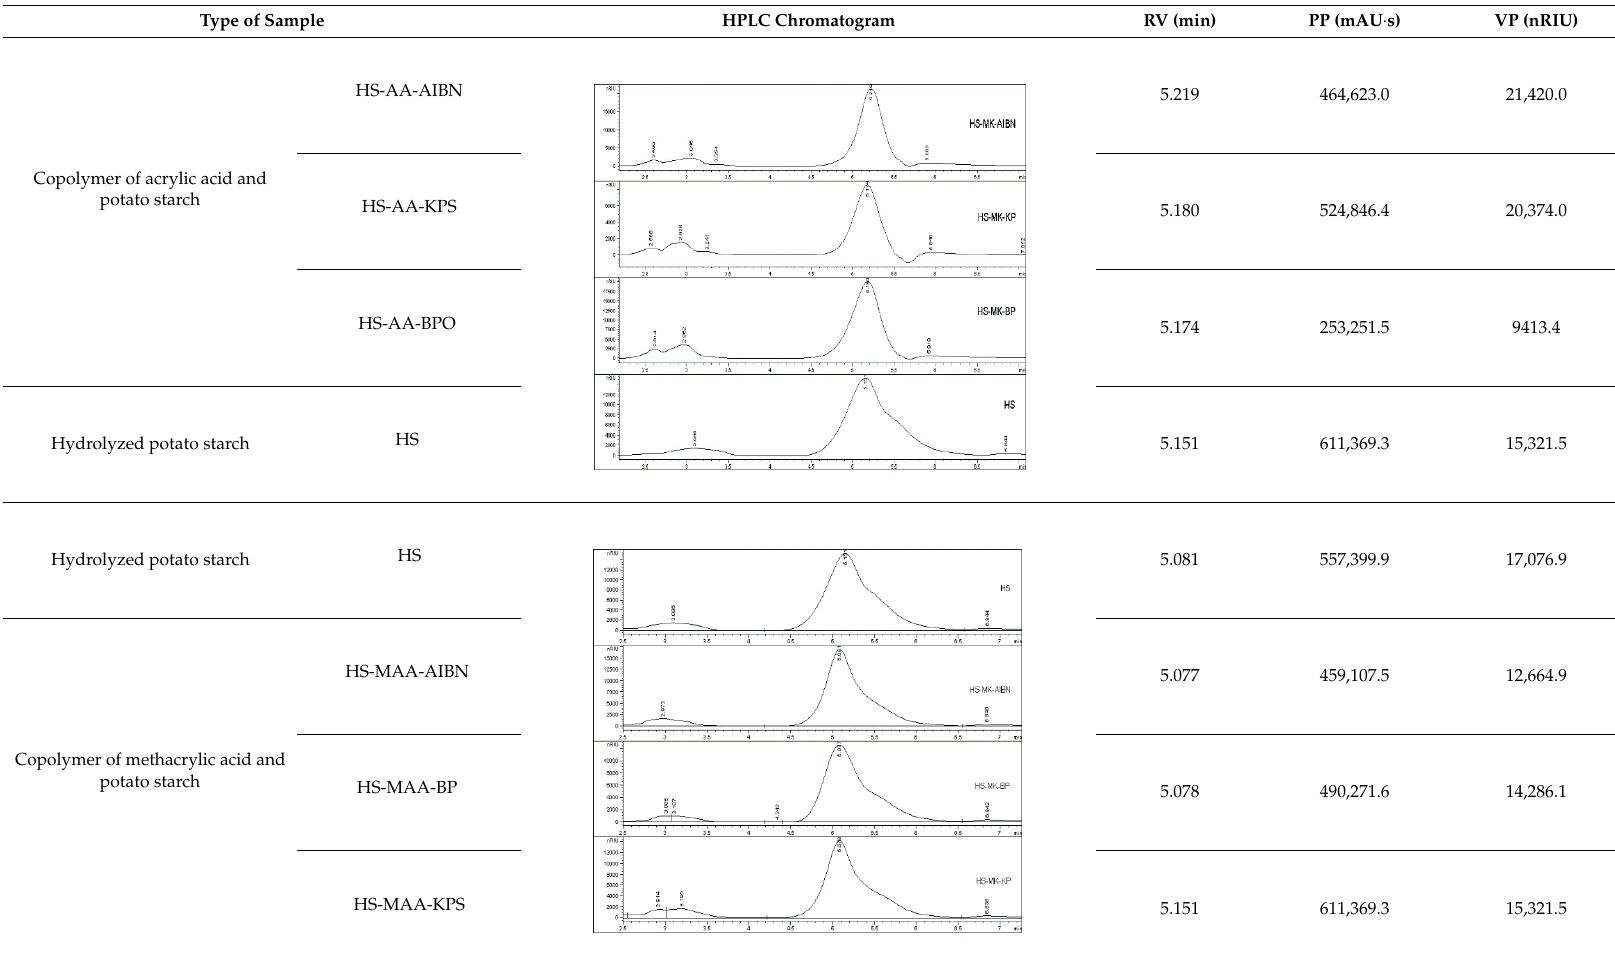
Table 4. HPLC chromatograms and single values from the chromatogram per samples and grafting initiators.